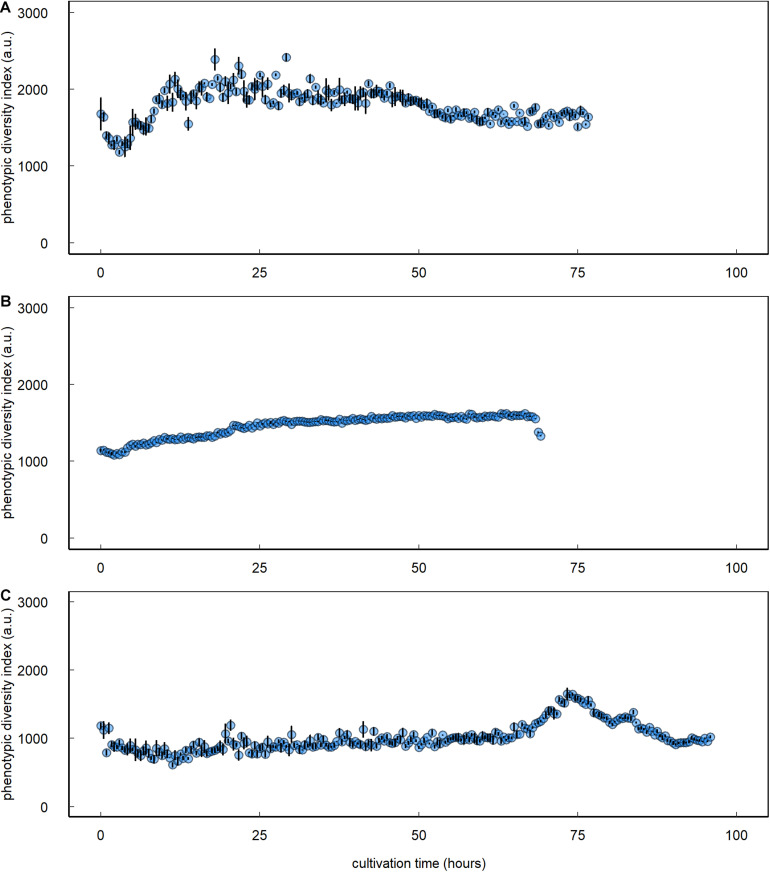
Prokaryotic phenotypic diversity index of C. vulgaris–prokaryote mixed ecosystems. Data are presented for single cocultures that were established from C. vulgaris with Sphingopyxis sp., Tistrella sp., and Pseudomonas sp. inoculated to (A) a lower or (B) higher initial concentration than C. vulgaris and (C) a coculture based on spontaneous, fortuitous contamination of axenic C. vulgaris cultures. Error bars denote bootstrap errors (n = 3).